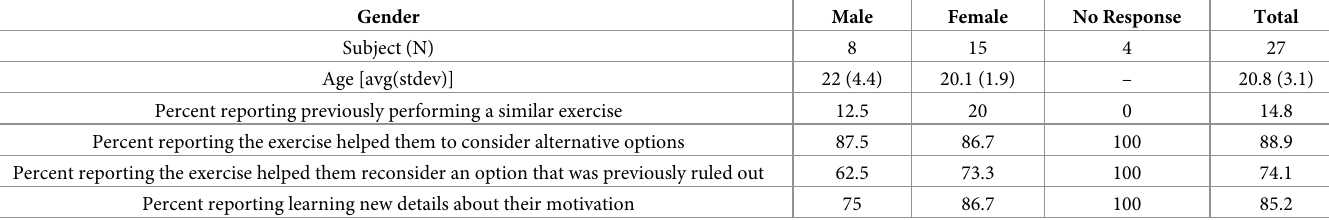
Table 1. Responses from the Future Life Map survey separated by gender. Raw data provided in S5 Appendix.